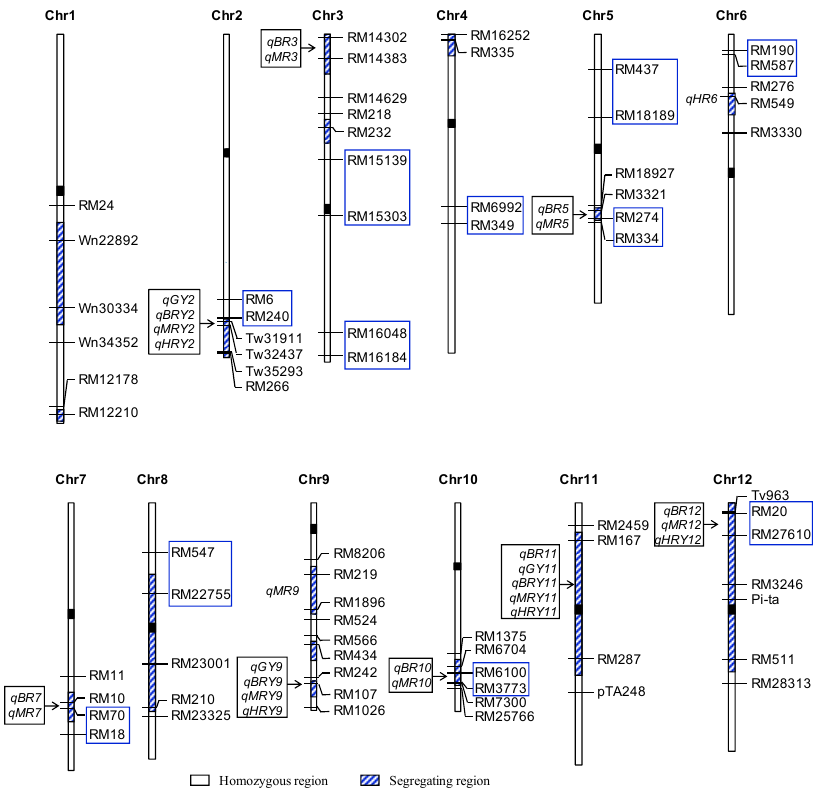
Figure 2. Genomic distribution of QTLs for seven traits detected in the RH-F 4:5 population. BR = Brown rice recovery; MR = Milled rice recovery; HR = Head rice recovery; GY = Grain yield per plant; BRY = Brown rice yield per plant; MRY = Milled rice yield per plant; HRY = Head rice yield per plant. Markers within the blue rectangle are flanking markers of QTLs detected in the TI population. Table 5. QTLs for seven traits detected in the RH-F 4:5 population.